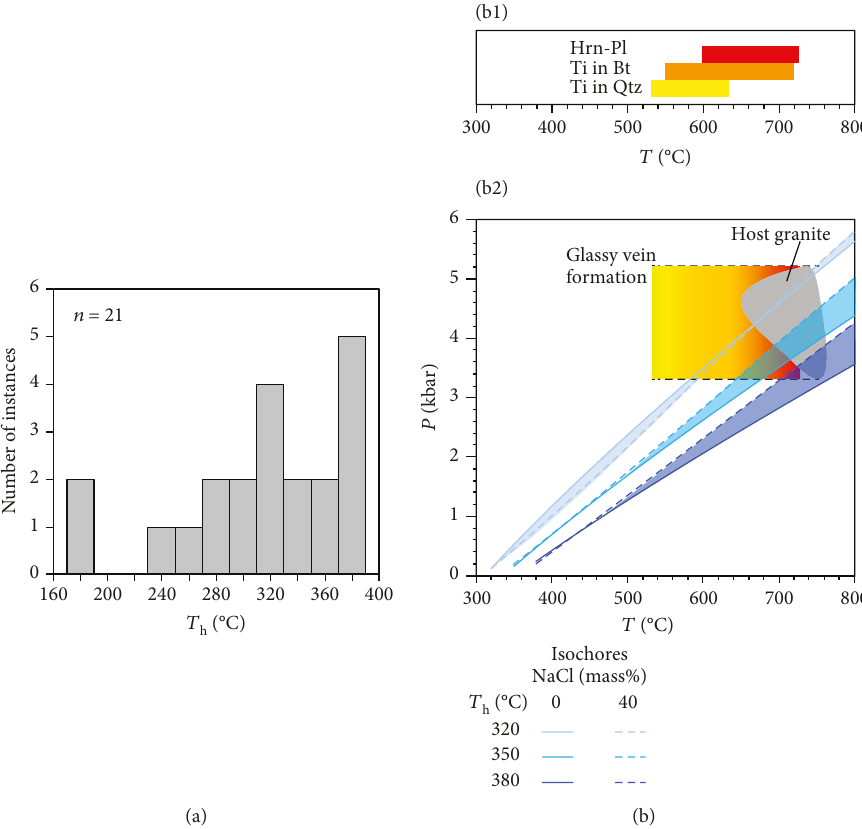
Figure 8: Homogenization temperatures of fl uid inclusions and summary of P – T conditions. (a) Histogram of T inclusions in glassy veins. (b) b1: summary of temperature constraints for glassy veins. b2: P – T plot showing the conditions for the formation of the host granite, glassy veins, and fl uid inclusions. The grey area indicates P – T conditions of the host granite determined using the amphibole-plagioclase thermometer and Al-in-hornblende barometer. The area in red and orange indicates P – T conditions for the glassy- vein formation constrained by amphibole-plagioclase, Ti-in-biotite, and Ti-in-quartz